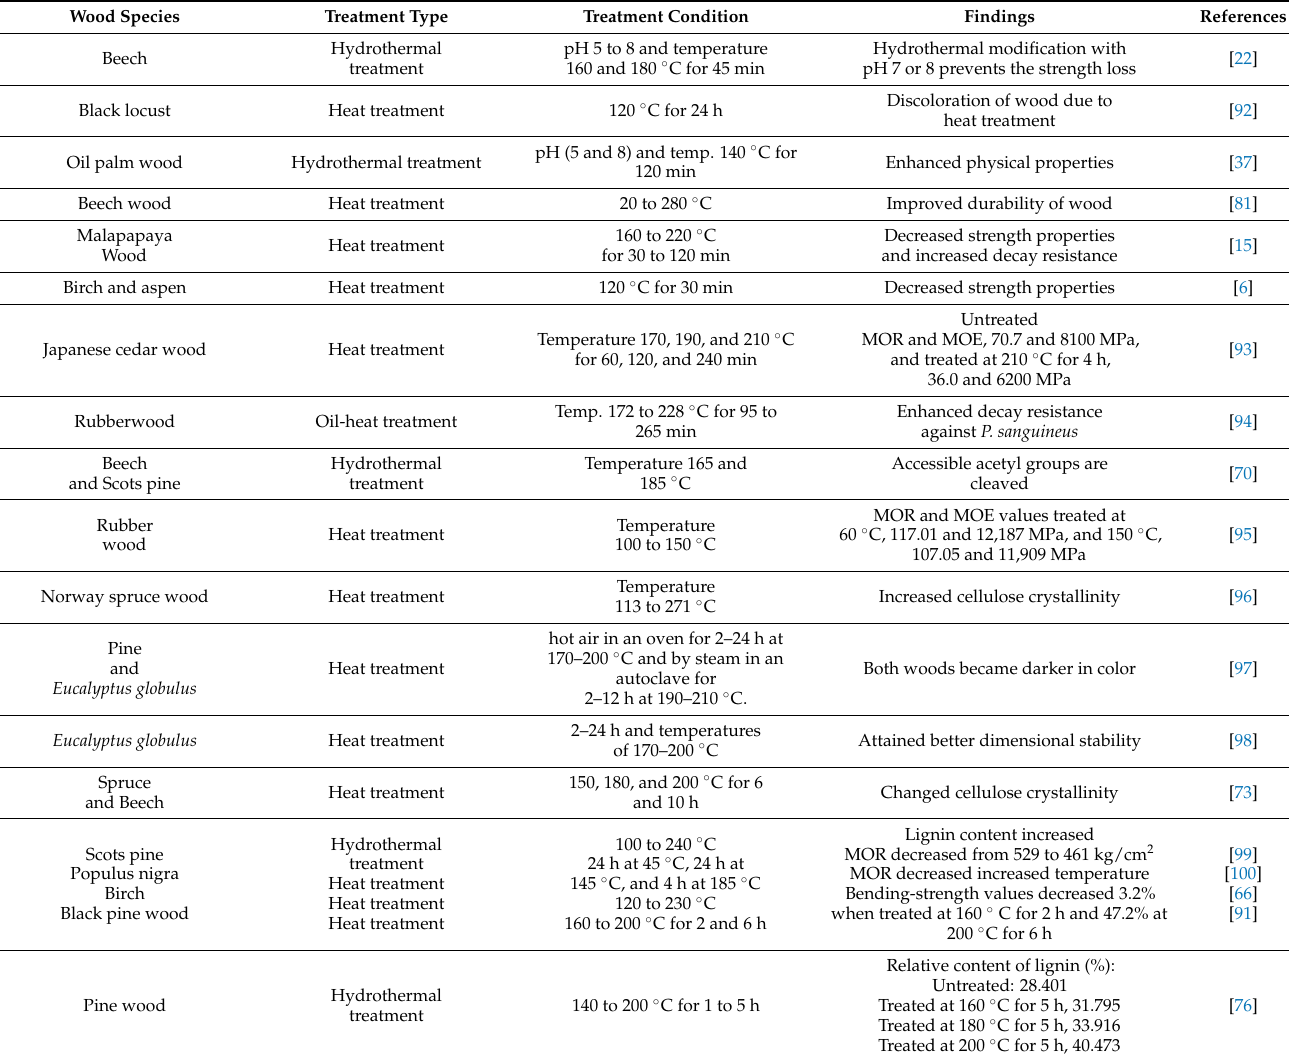
Table 4. Findings regarding the properties of wood subjected to different modification